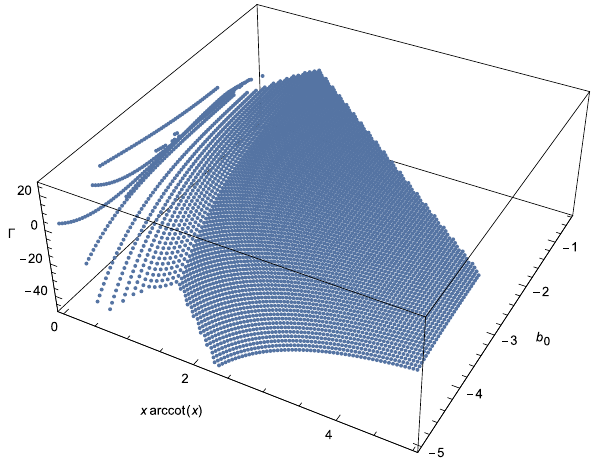
Fig. 2 Dependence of (cid:14) on the renormalization scale and scheme ( N = 3 case, in units of (cid:25) MS